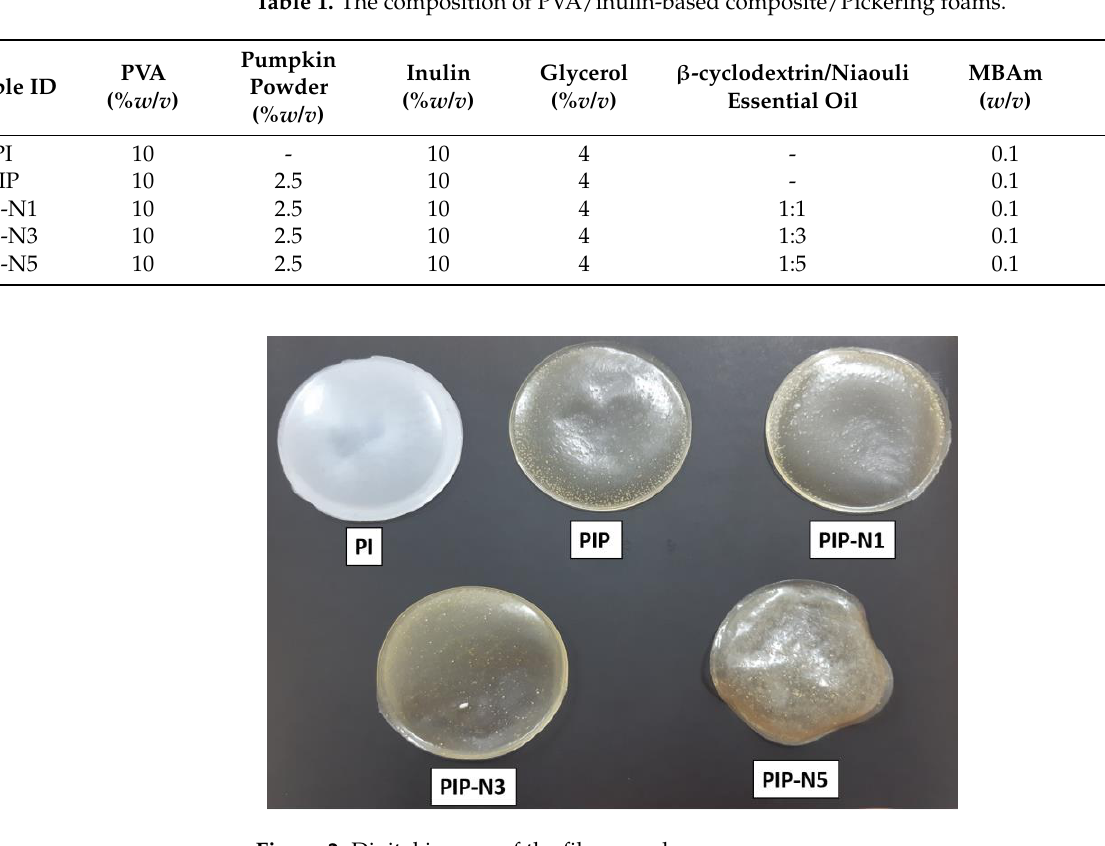
Figure 1. Schematic illustration of Pickering films. Table 1. The composition of PVA/inulin-based composite/Pickering foams. Table 1. The composition of PVA/inulin-based composite/Pickering foams.